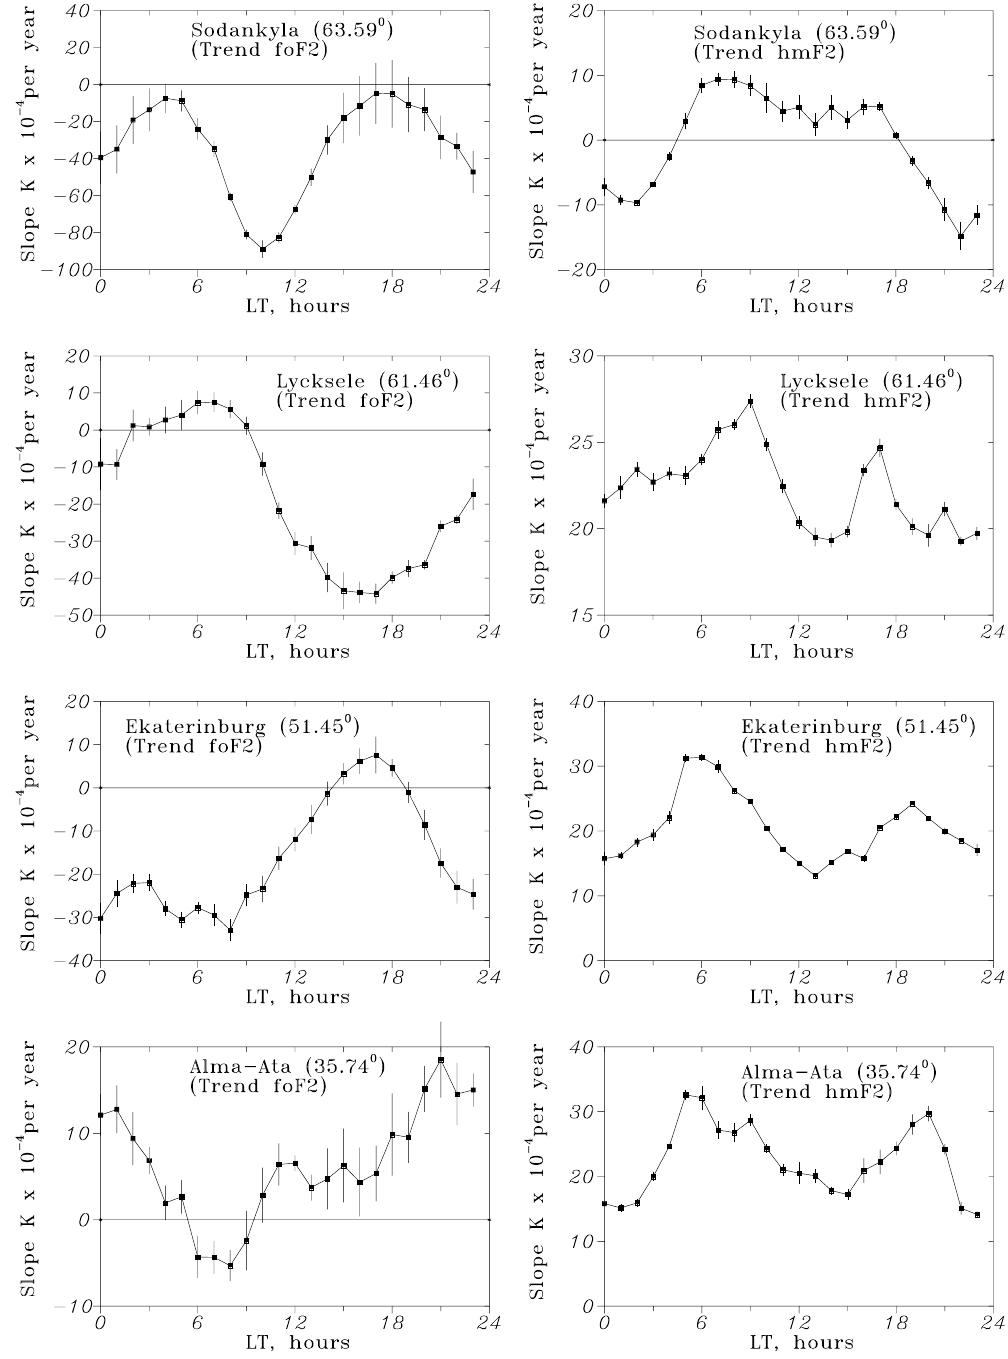
Fig. 1. Diurnal variation of annual mean slope K for fo F2 (left panel) and hm F2 (right panel) trends at auroral, sub-auroral, mid-latitude and lower latitude stations for the 1965–1991 period, invariant latitudes are given in brackets. Error bars present the standard deviation of seasonal (over 12 months) scatter in the slope K